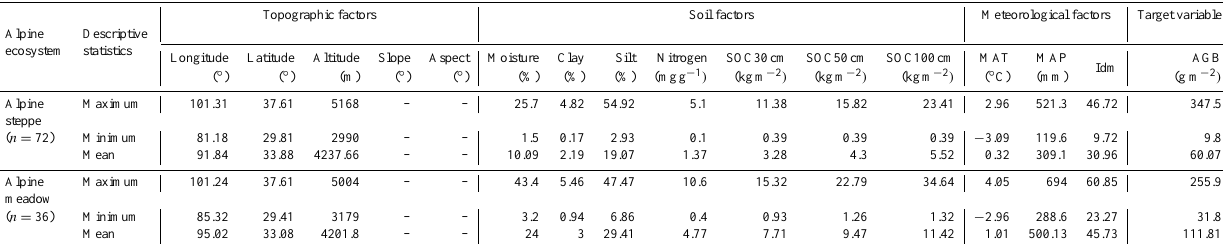
Fig. 2. Comparison of the simulated results of the topographic factors: altitude (A) , aspect (B) , and slope (C) with the observed values (with good fittings, R 2 = 0 . 9885) obtained only for altitude. Table 1. Descriptive statistics of the environmental factors and